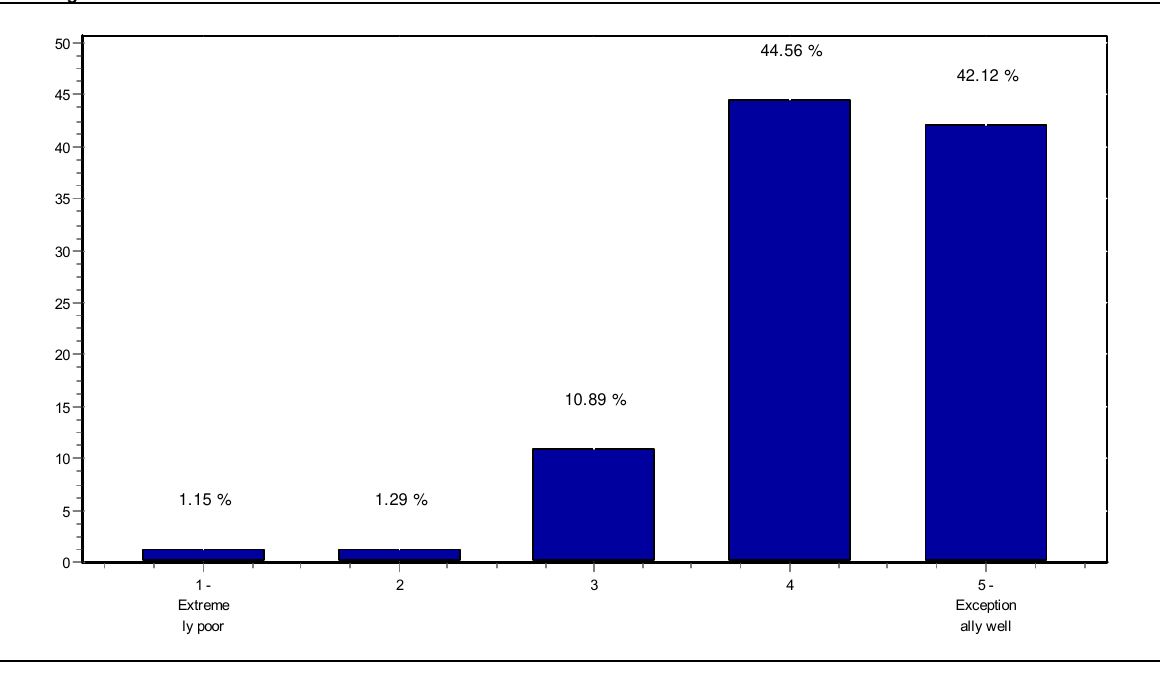
Fig. 5. Knowledge of staff at